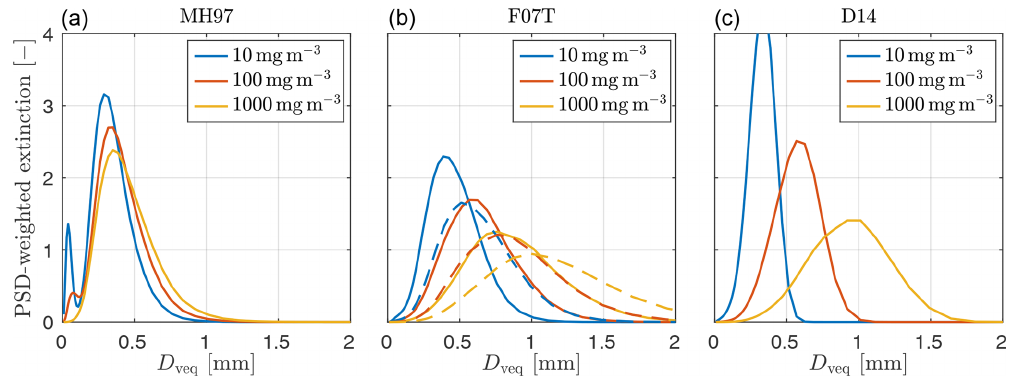
Figure 2. Normalized extinction as a function of volume-equivalent diameter D veq for different combinations of particle size distribution and IWC. Frequency is 190.31GHz, temperature 255K, and the assumed particle model is the ICON cloud ice. Each extinction curve is normalized to have an area equal to 10 − 3 . (b) Extinction calculated using the 8-column aggregate is included, indicated by dashed lines, for comparison.